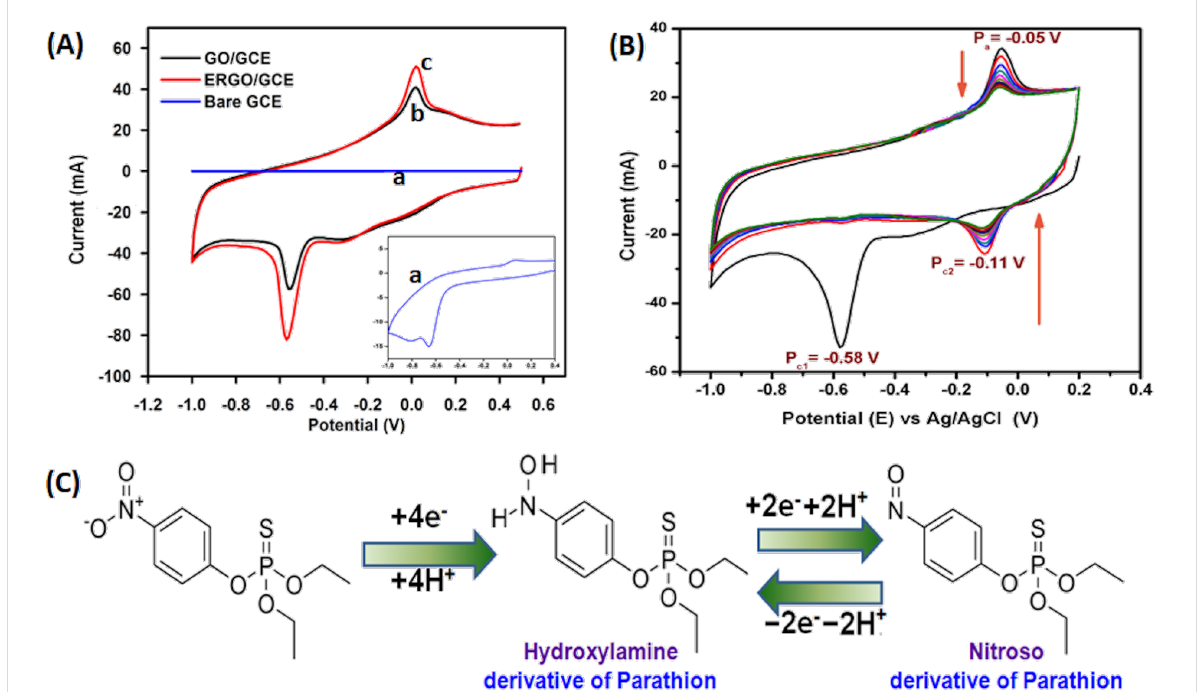
Figure 5: (A) Cyclic voltammograms of PT (10 mM) with bare GCE (a), GO/GCE (b), and ERGO/GCE (c). (B) Electrochemical behavior of PT at ERGO/GCE. (C) Schematic diagram of the proposed electrochemical reaction of parathion at ERGO/GCE.